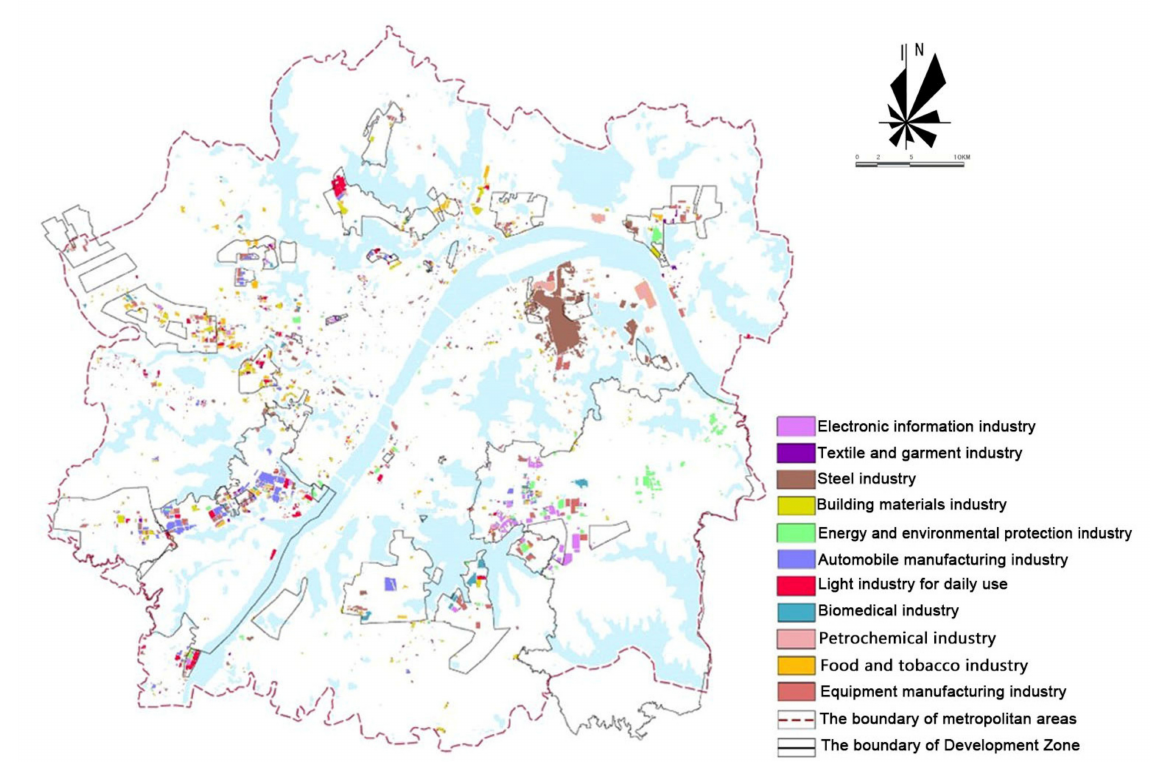
Figure 6. Relationship between manufacturing industry and Development Zone distribution.